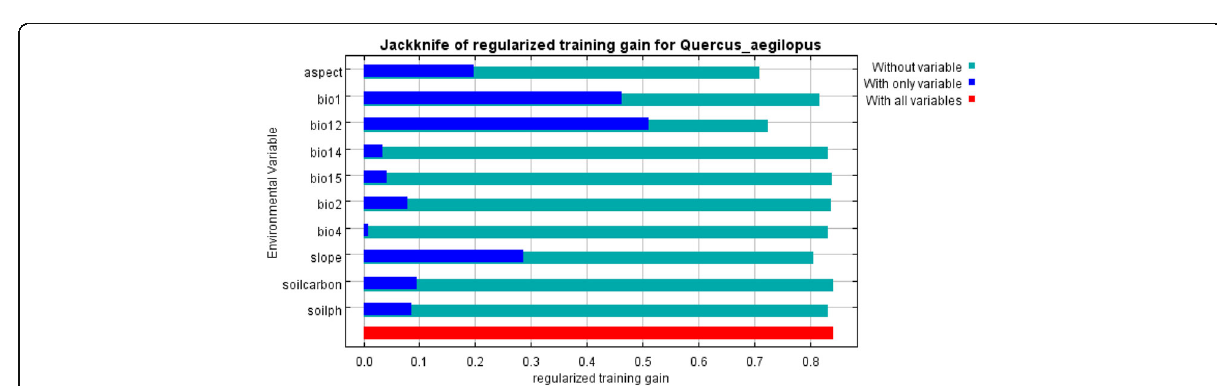
Fig. 9 Relative importance (%) of the predictors from the Jackknife test to regularize the training gains. The gain (%) with all predictors= Red bar; the gain (%) with only predictor= Blue bar; the gain (%) without the corresponding predictor = Green